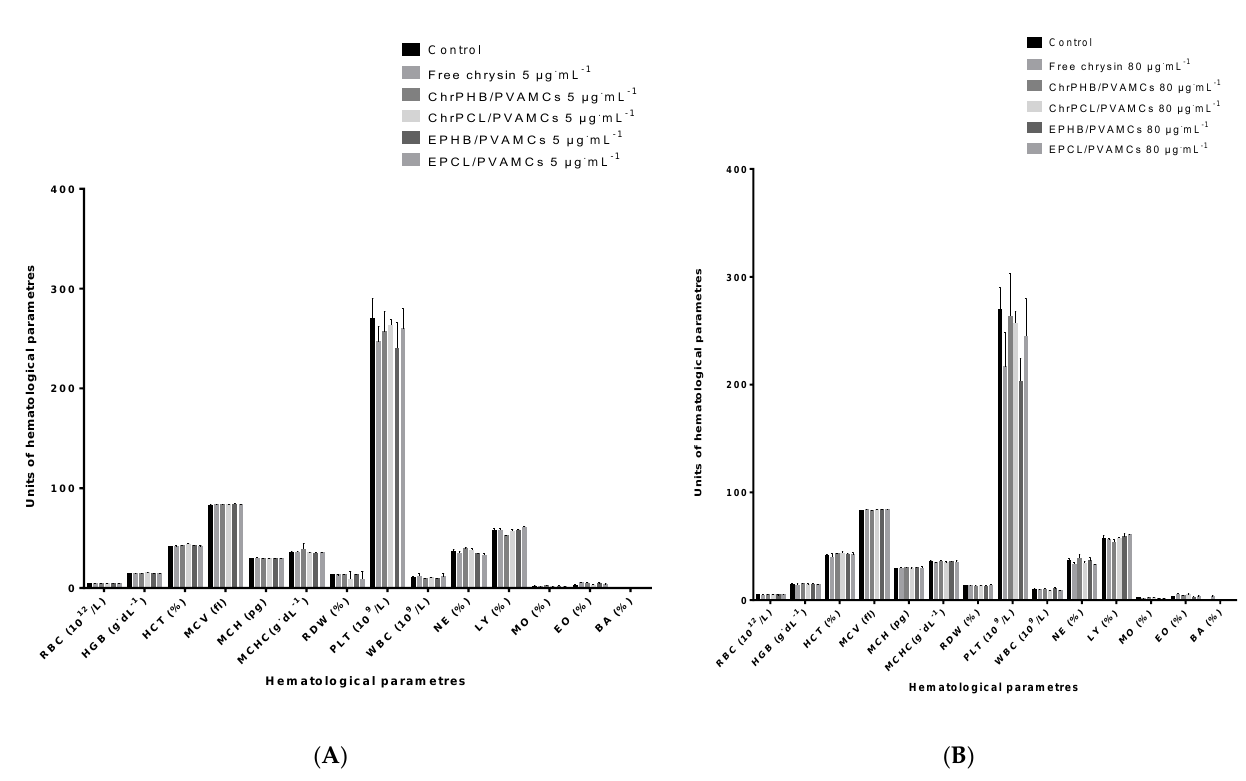
Figure 8. Hematological parameters after the treatment of human blood samples with two concentrations, ( A ) 5 µg • mL −1 and ( B ) 80 µg • mL −1 , of free chrysin, ChrPCL/PVAMCs, or ChrPHB/PVAMCs and their empty counterparts. RBC: red blood cells (10 12 /L); HGB: hemoglobin (g • dL −1 ); HCT: hematocrit (%); MCV (fl); MCH (pg); MCHC (g • dL −1 ); RDW (%); PLT (10 9 /L); WBC (10 9 /L); NE (%); LY (%), MO (%), EO (%), and BA (%).